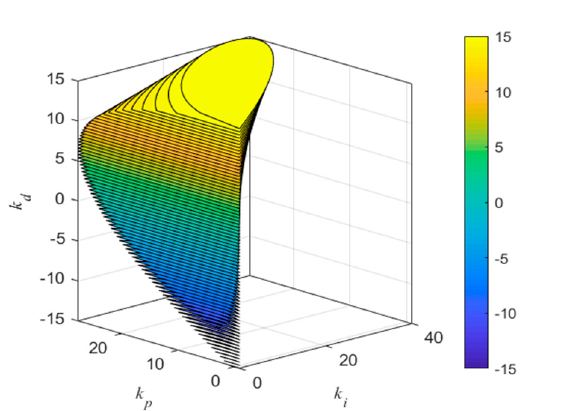
Figure 2. Stability region of k p and k i with di ff erent k d .